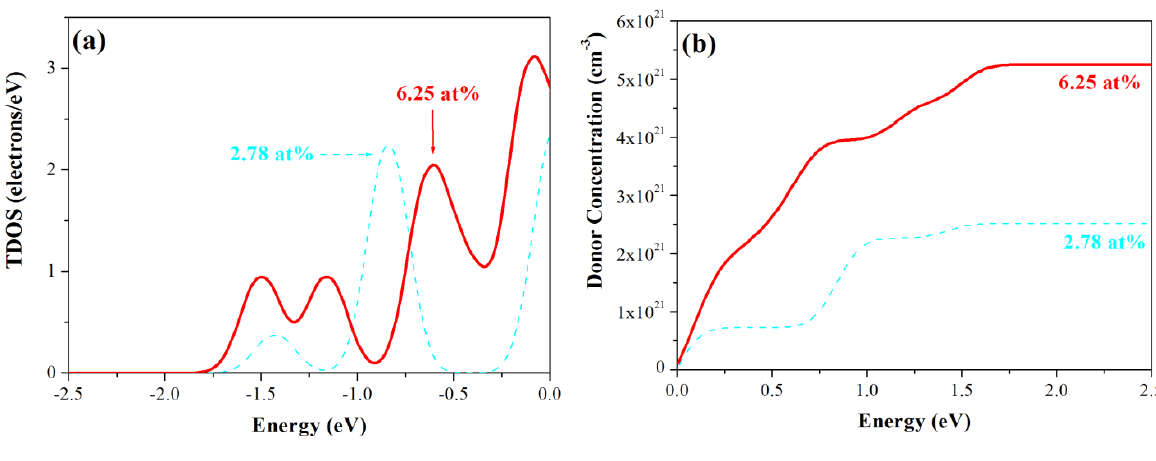
-2.78 at% and -6.25 at% s(Zn)